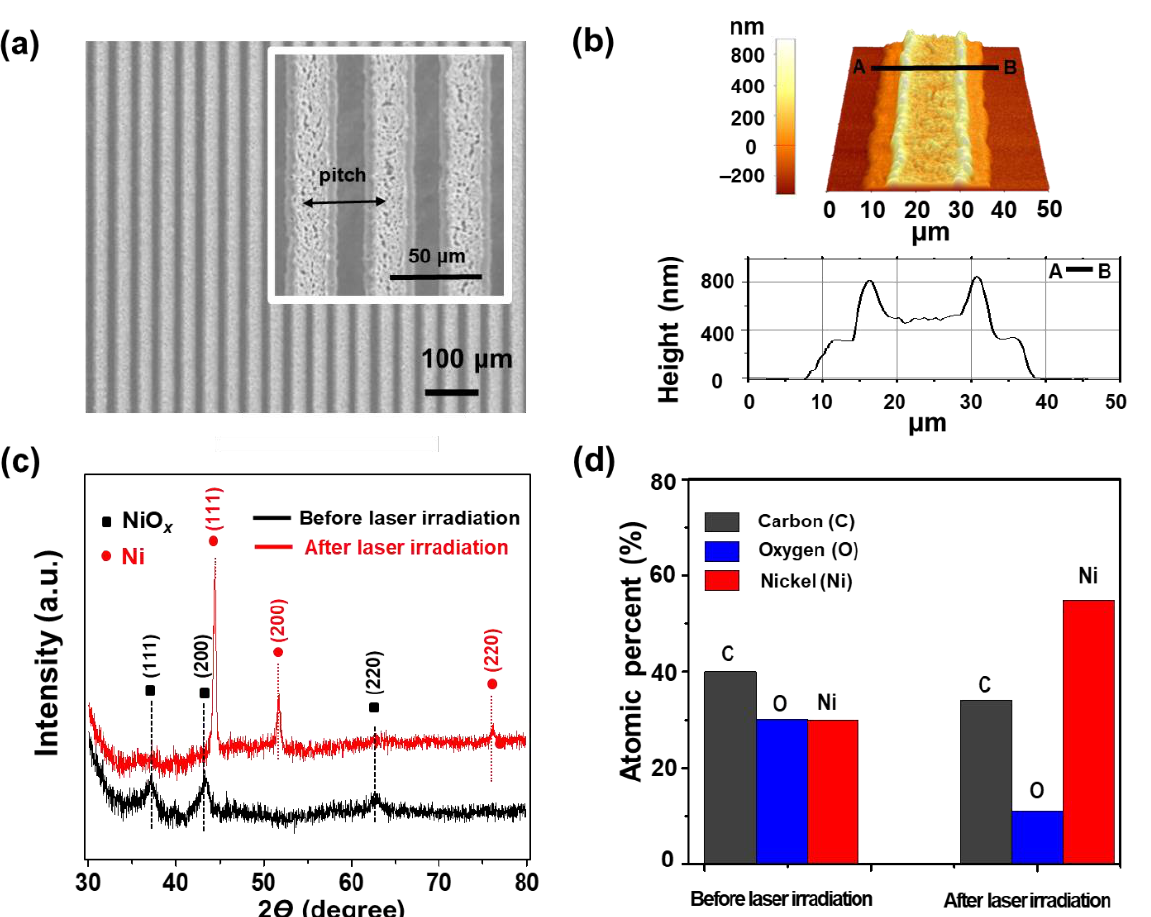
Figure 3. ( a ) Scanning electron microscopy (SEM) image of multiple Ni electrodes on the polyimide (PI) substrate. The inset is the SEM image at a higher magnification. ( b ) Atomic force microscopy (AFM) image of a single Ni electrode and the corresponding cross-sectional profile. ( c ) X-ray diffraction (XRD) patterns before and after the laser-induced reductive sintering of the NiO x nanoparticle (NP) thin film. ( d ) Comparison of a chemical composition detected by X-ray spectrometry (EDS) measurement before (left columns) and after (right columns) laser-induced reductive sintering of the NiO x NP thin film.